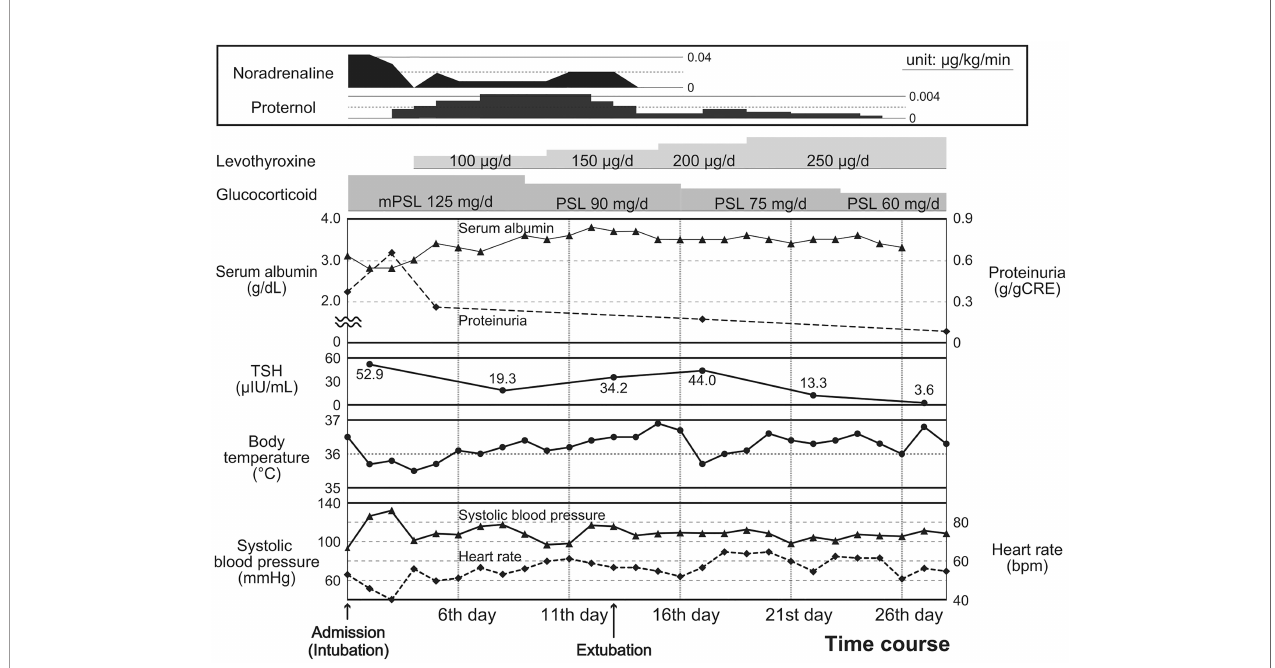
FIGURE 2 | Clinical course after admission. Physical fi ndings: body temperature (closed circles with solid lines), systolic blood pressure (closed triangles with solid lines), and heart rate (square with broken lines) [lower]; laboratory fi ndings: serum albumin (closed triangles with solid lines), proteinuria (square with broken lines), and TSH levels (closed circles with solid lines) [middle]; and the contents of medication therapies [upper] are presented.